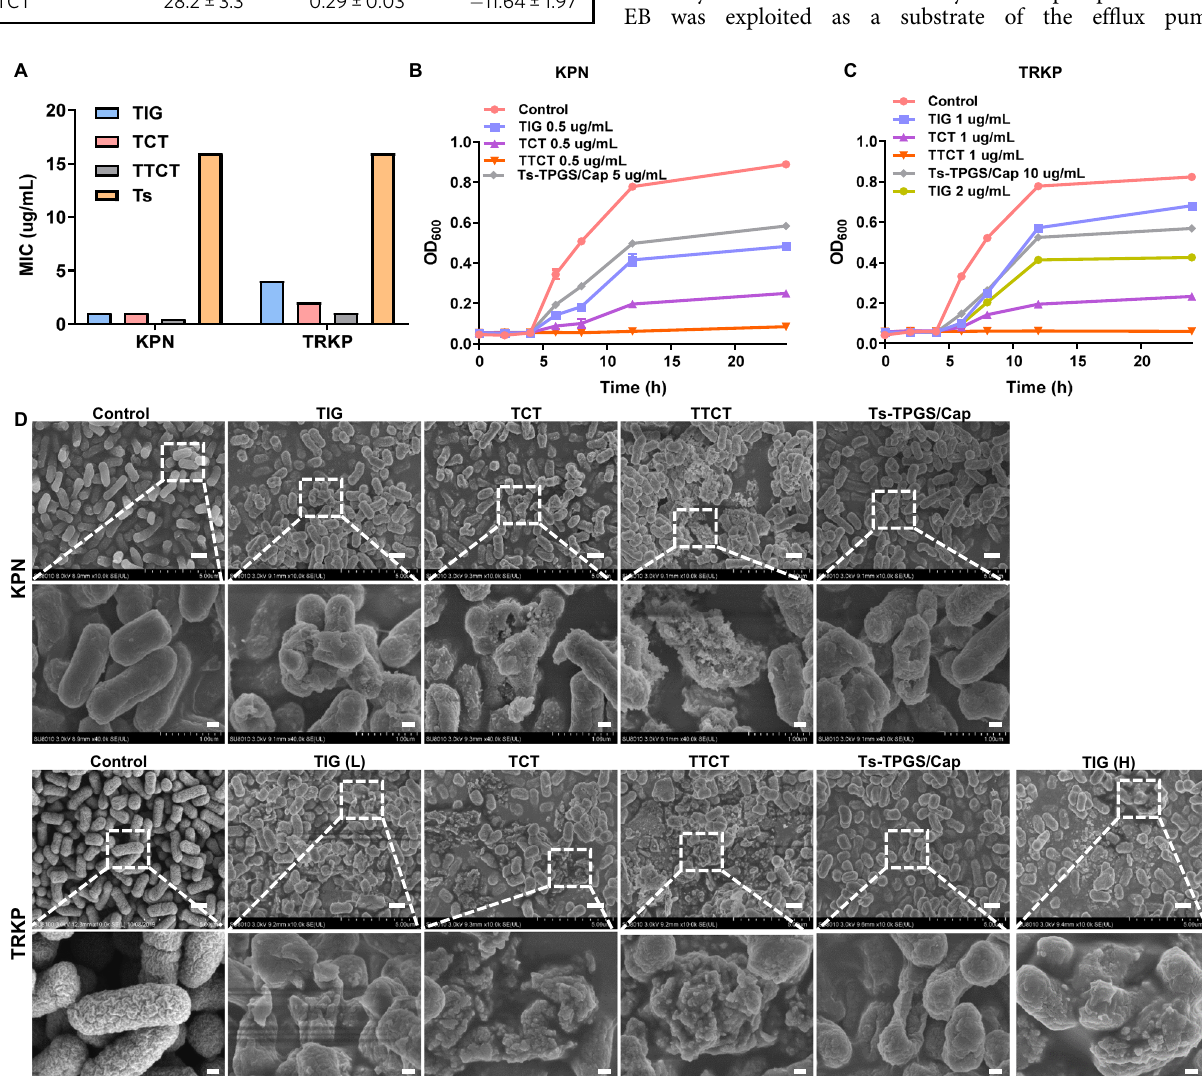
Fig. 4 Evaluation of the antibacterial activity of TTCT towards KPN and TRKP in vitro. A MIC susceptibility semiquantitative pro fi les of TTCT via the microplate broth dilution method ( n = 3 independent experiments, and the results were similar). Growth curves of KPN ( B ) and TRKP ( C ) co-incubated with various preparations. D Representative SEM images of KPN and TRKP after treatment with TIG, TCT, TTCT, and Ts-TPGS/Cap nanorods. Scale bar on the original SEM images and the enlarged images were 10 μ m and 2 μ m, respectively. TIG free tigecycline, Ts-TPGS/Cap Ts-TPGS functionalized calcium phosphate nanorods, TCT tigecycline loaded TPGS/Cap nanorods, TTCT tigecycline-loaded Ts-TPGS/Cap nanorods, KPN Klebsiella pneumonia , TRKP tigecycline-resistant Klebsiella pneumonia . The experiments in A – D were repeated independently for three times with similar results. Source data are provided as a Source Data fi le.